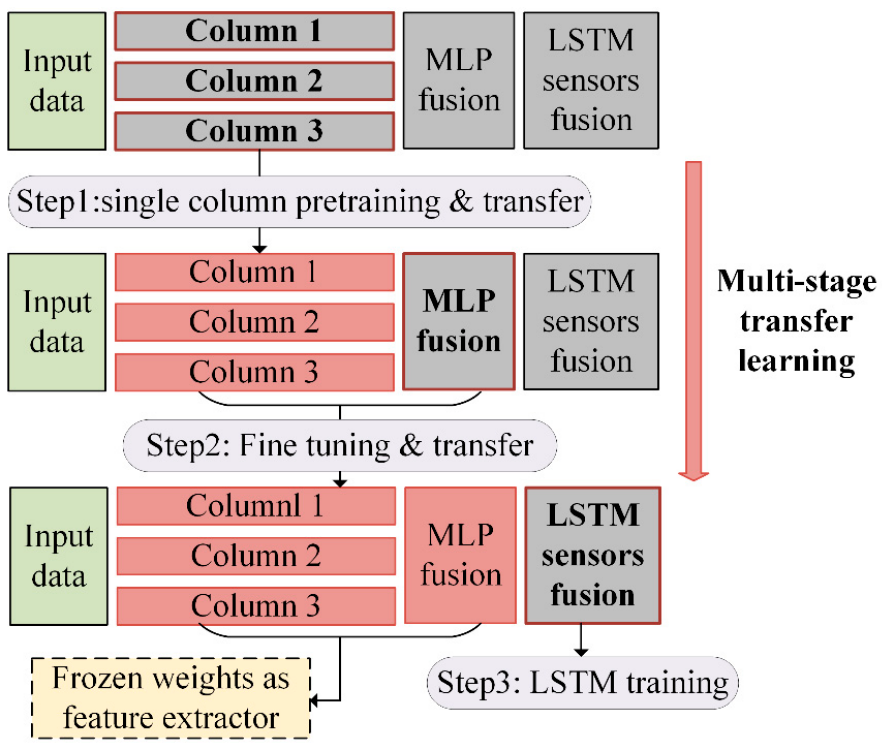
Figure 6. Three stages of the knowledge transfer process.